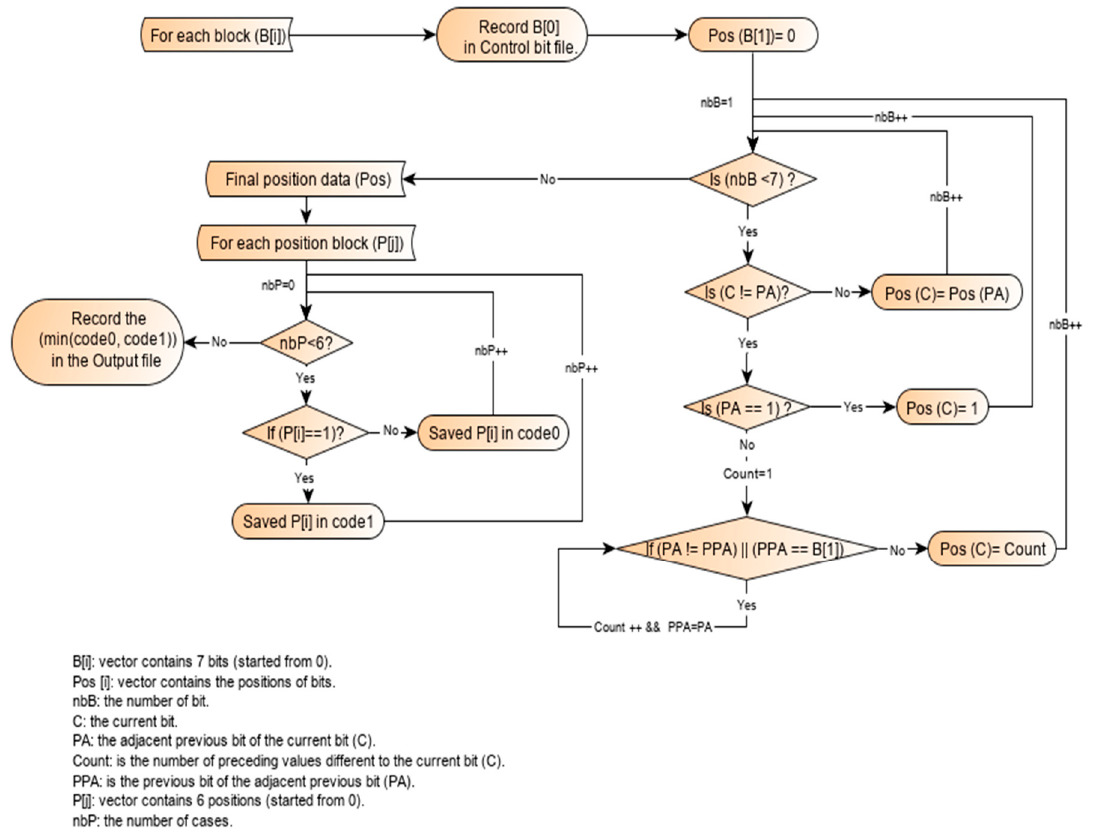
Figure 3. The encoding block process using the single-block encoding scheme (SBE).